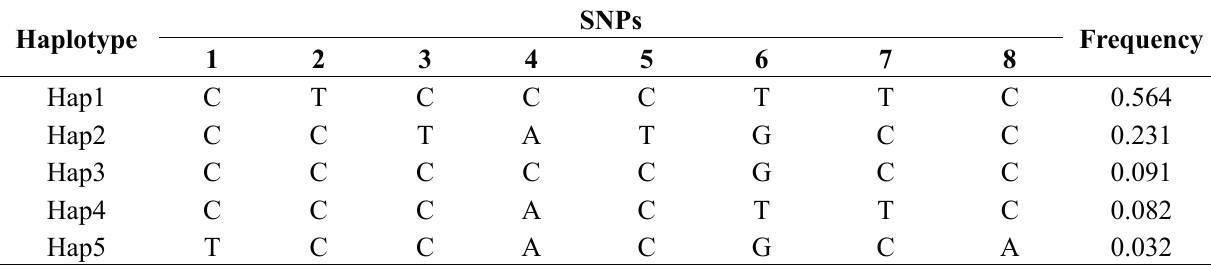
Table 3. Information of haplotypes of the SMO gene in Qinchuan cattle population.